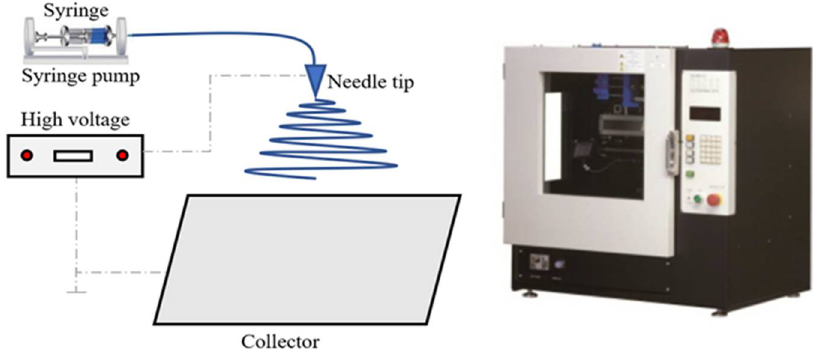
Figure 2. Electrospinning device and mechanism.